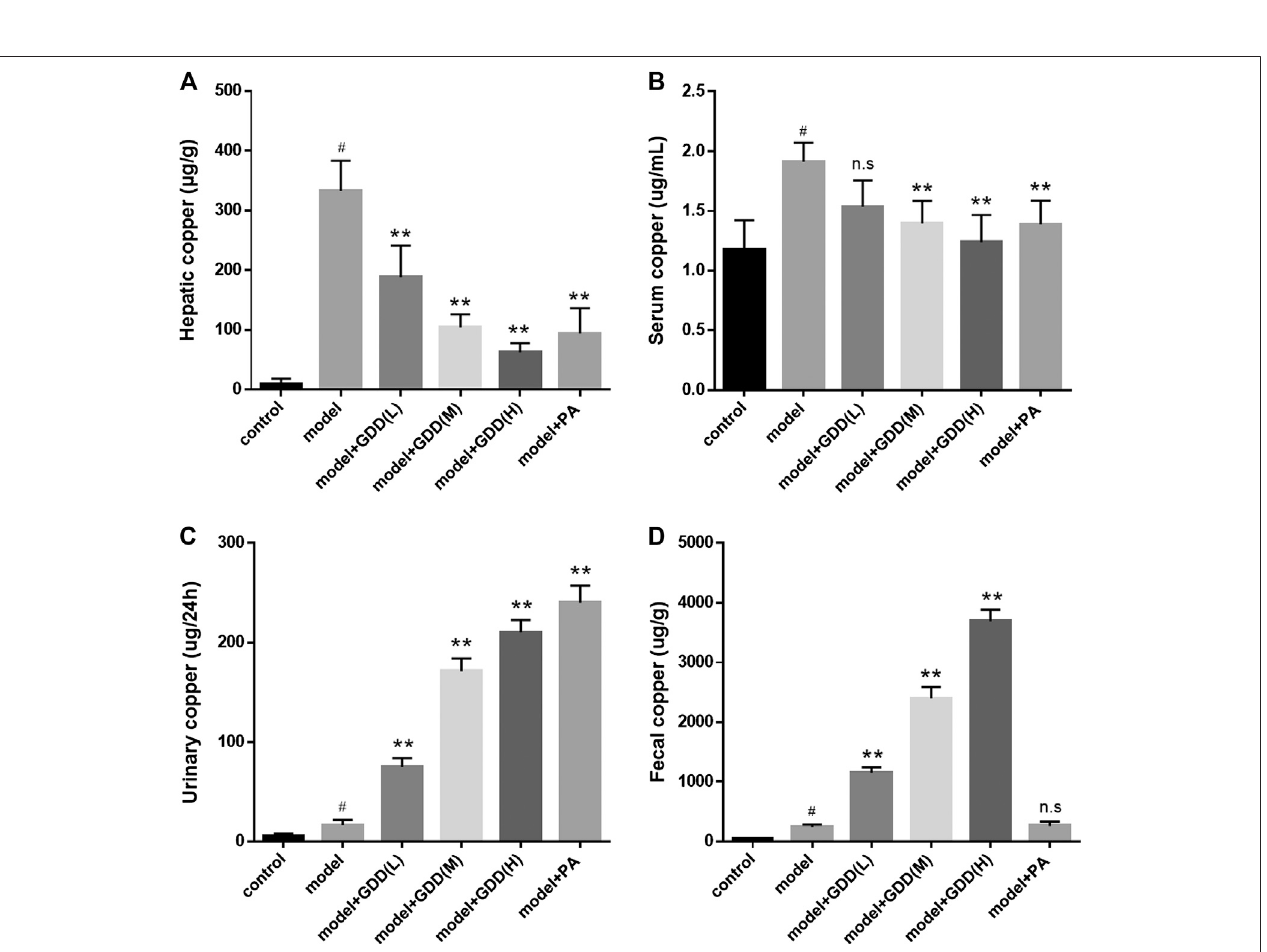
FIGURE 4 | (A) Copper content in liver. (B) Copper content in serum. (C) Copper content in urine. (D) Copper content in feces. # p < 0.01, compared with the control group; ** p < 0.01, compared with model group; n.s, not signi fi cant.